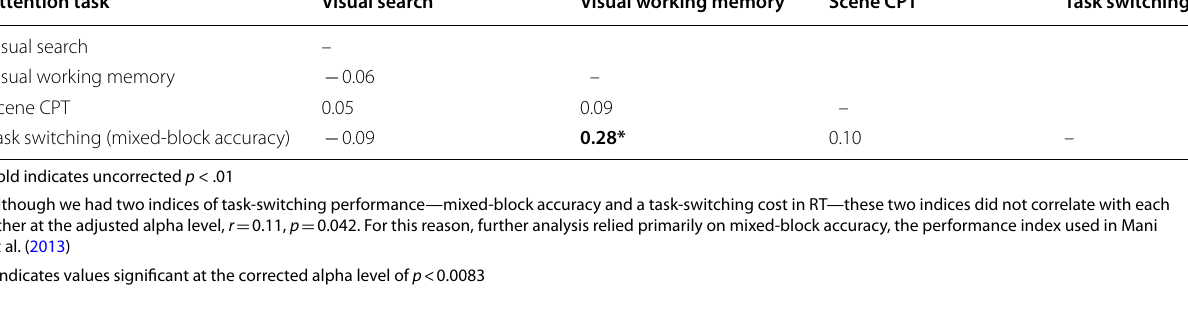
Table 2 Pearson’s correlation coefficients between the four attention task performance measures